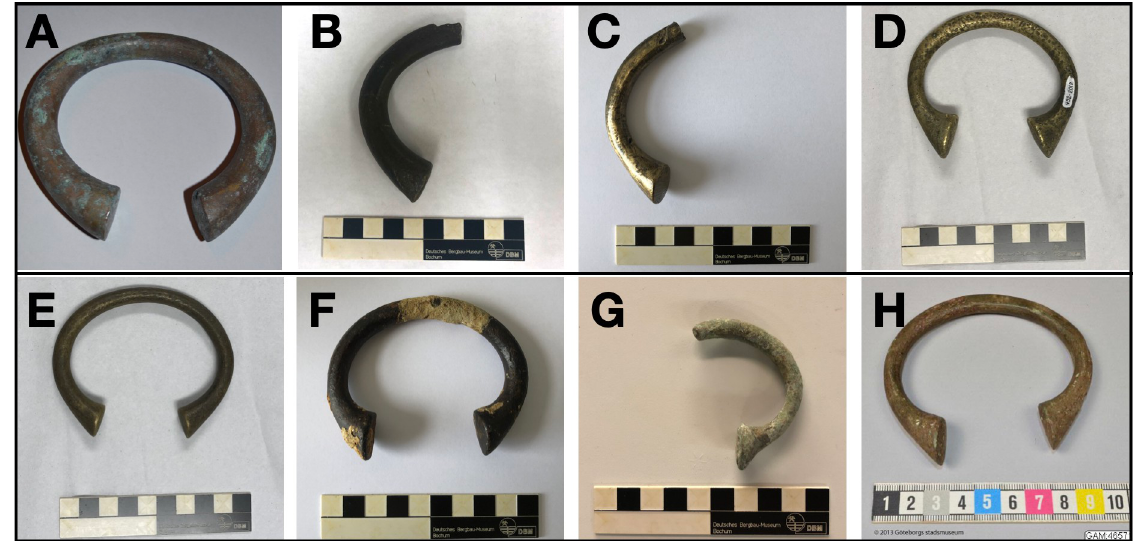
Fig 1. Examples of sampled manillas from the seven sites. a) Getaria, tacoais-type b) Elmina, Town Site, tacoais type c) Elmina wreck, tacoais type d-e) Cape Cod, both popo-type f) Site 35F, popo-type, g) Scilly Isles, Birmingham-type h) Gro¨to¨, popo-type. Some findspots produced various typologies. Scale is